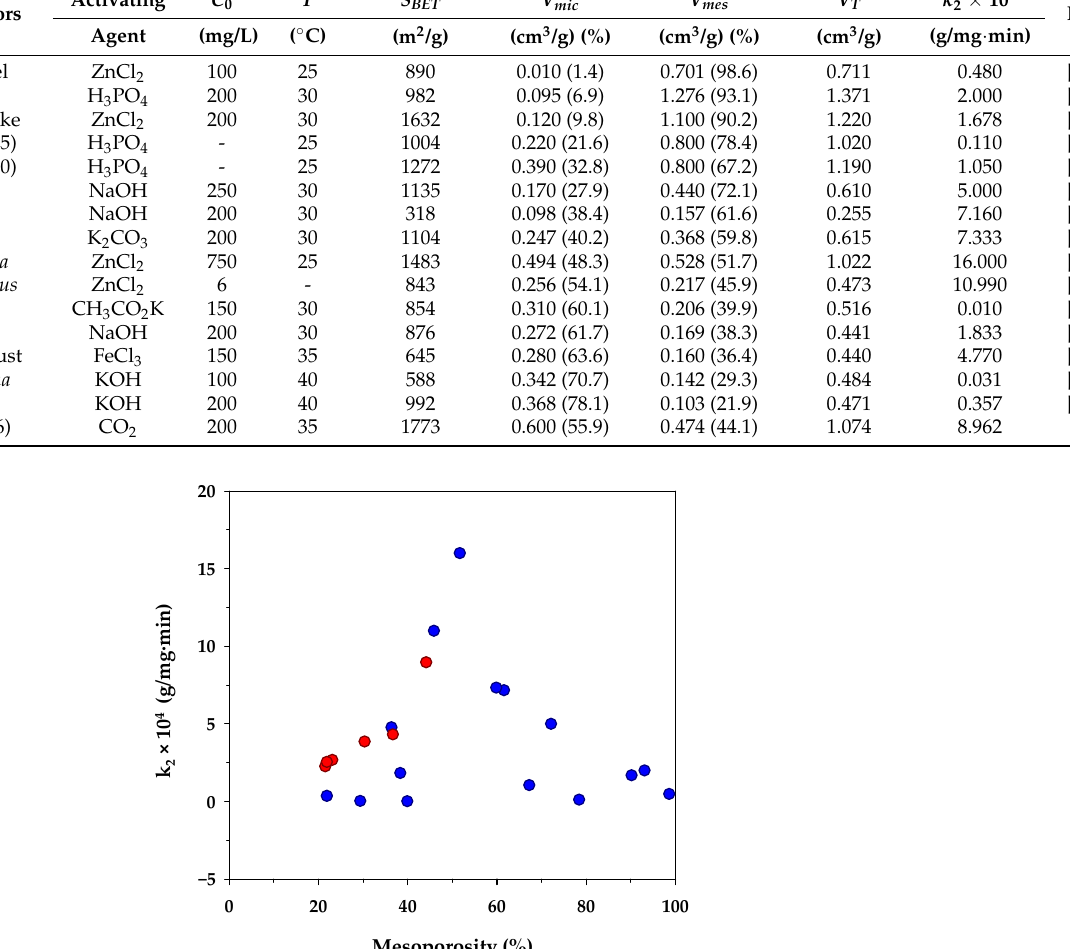
Table 6. Comparison of the kinetic parameter ( k 2 ) of the pseudo-second-order model for various types of activated carbons. Biomass Precursors